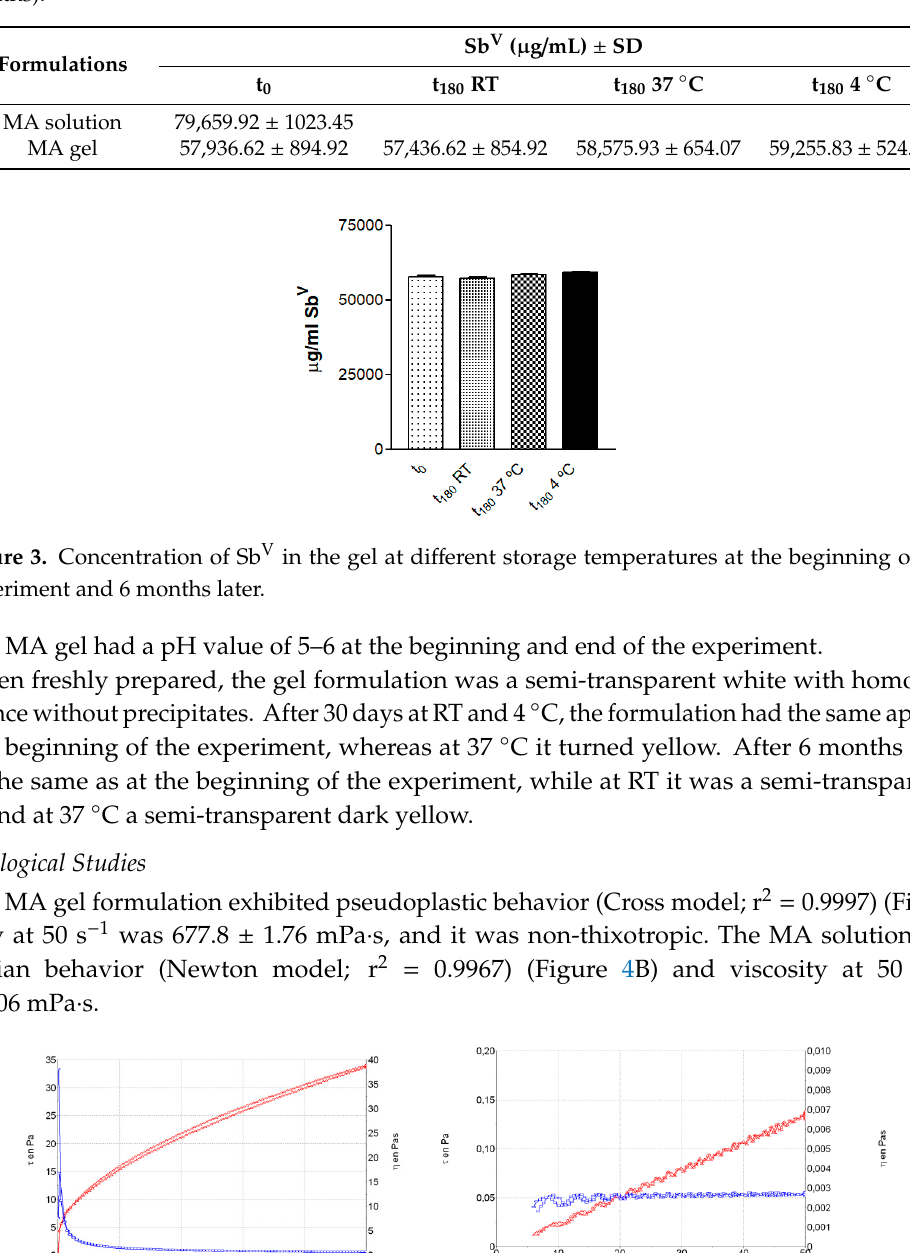
Figure 2. ( A ) Swelling ratio and ( B ) percentage of weight loss in the degradation of MA gel.